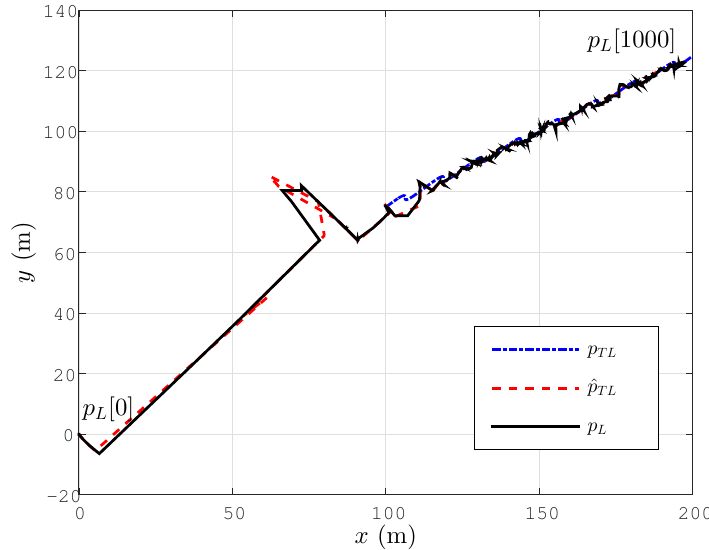
Figure 8. Lateral tracking control for a drifting target for the simplified motion dynamics model Equation